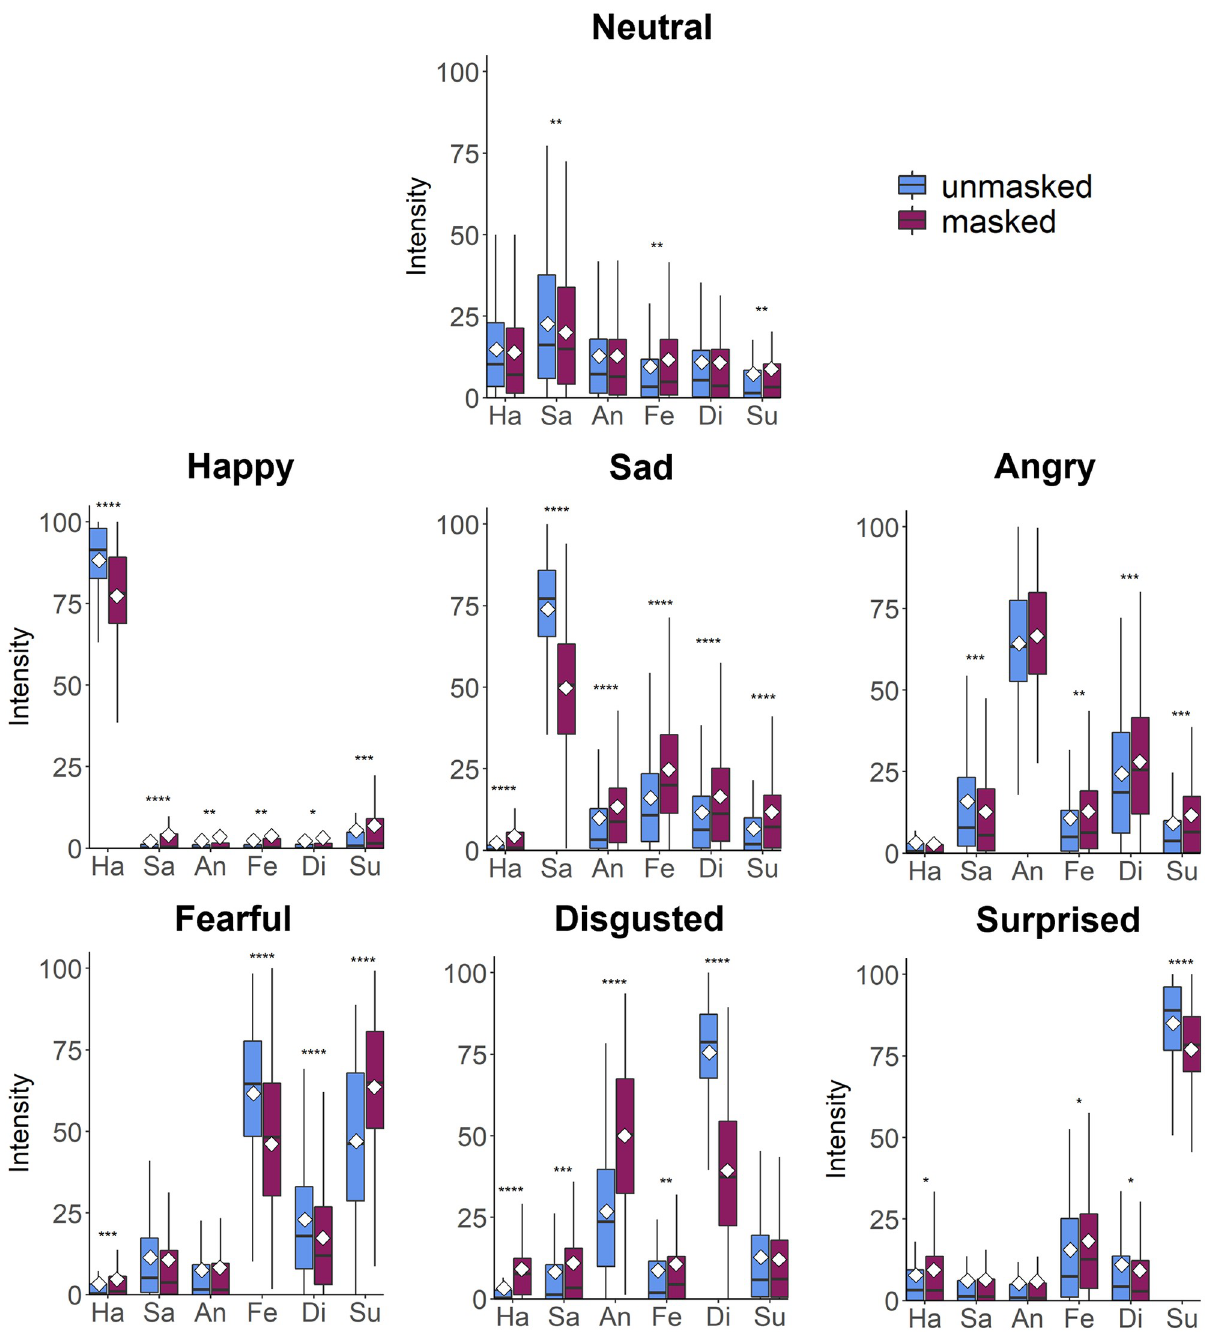
Fig 1. Intensity ratings for unmasked and masked faces. The mean of each distribution is depicted with a white square. The boxes show the median and the interquartile range. The whiskers show the furthest values that are within 1.5 x the interquartile range on either side of the box. Asterisks show significant contrasts between unmasked and masked ratings after FDR correction for six comparisons for each facial expression. Ha: happiness, Sa: sadness, An: anger, Fe: fear, Di: disgust, Su: surprise. � p � .05, �� p � .01, ��� p � .001, ���� p � .0001.